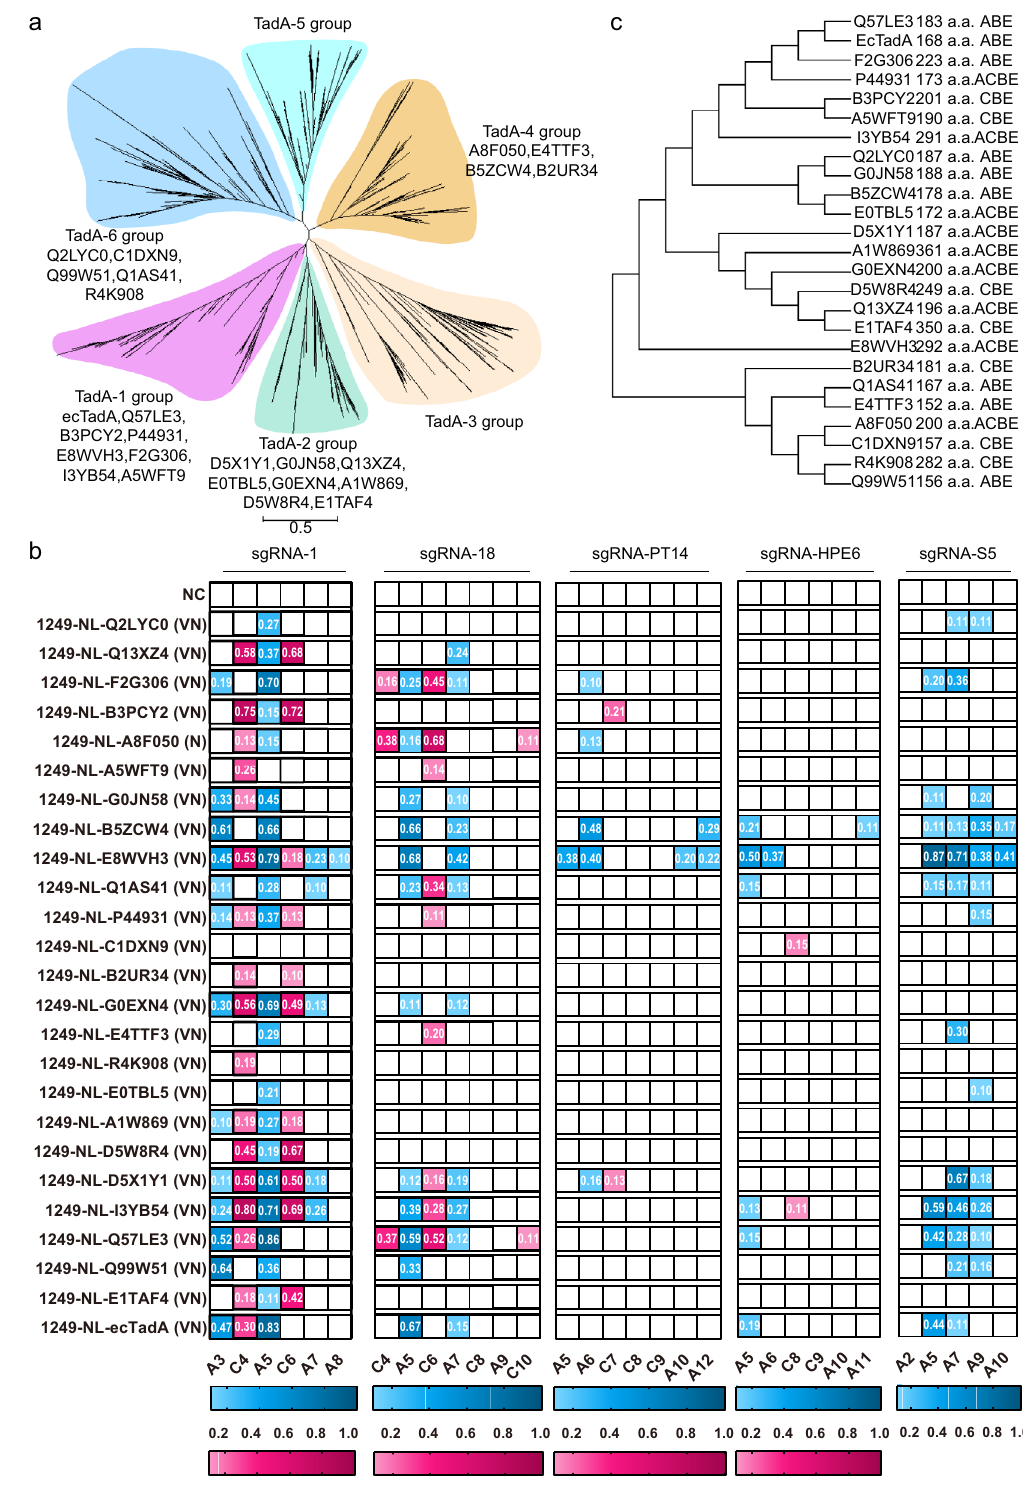
Fig. 2 | Engineering of TadA orthologs for functional ABEs, CBEs, and ACBEs. a Phylogenetic analysis of TadA orthologs with a maximum-likelihood tree and six TadA groups were de fi ned. The evolutionary distance scale of 0.5 was shown.